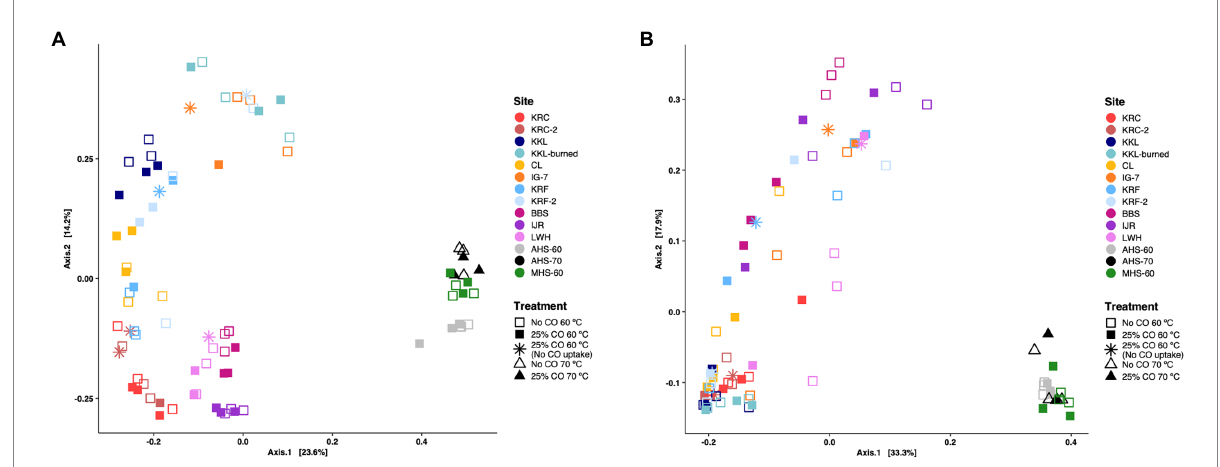
FIGURE 4 Principal coordinates analyses (PCoA) based on UniFrac distances for microbial communities derived from samples incubated under thermophilic conditions with or without 25% CO. (A) unweighted UniFrac metric; (B) weighted UniFrac metric. Samples are grouped by treatment and site; site abbreviations are described in the legend for Figure 1.